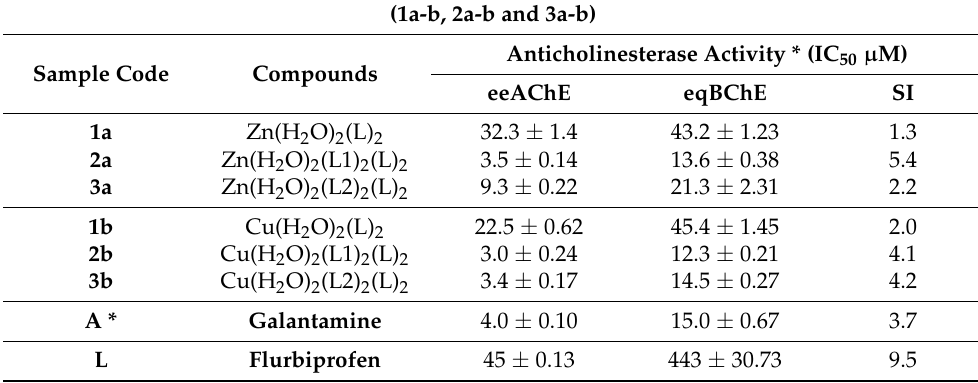
Table 2. In vitro AChE and BChE inhibitory activities of